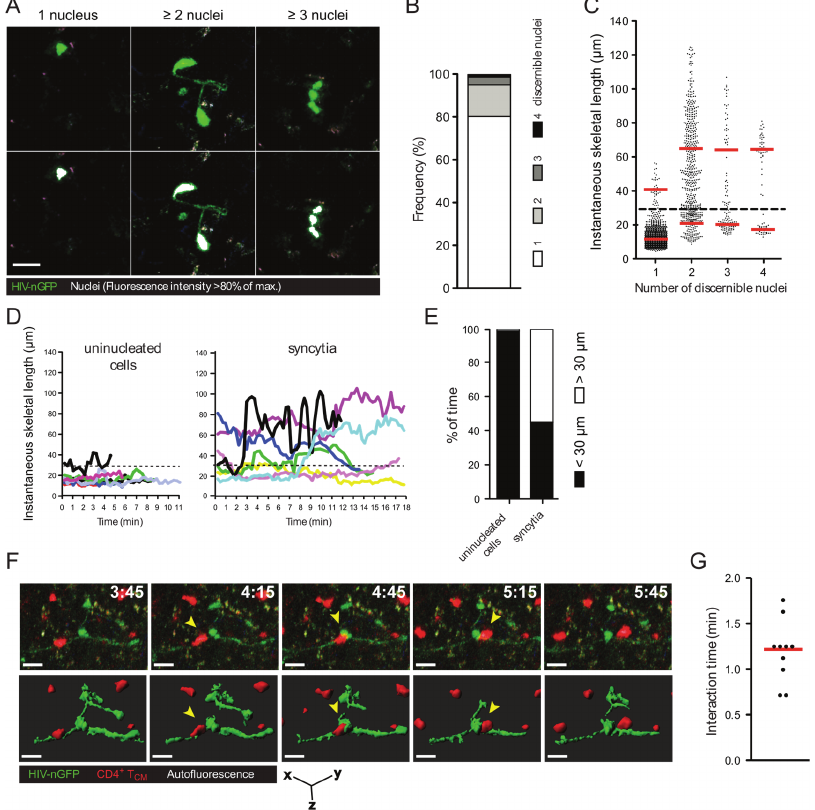
Figure 1. Morphology, frequency, and cellular interactions of HIV-1-induced syncytia in the lymph node. ( A ) Intravital micrographs of lymph node cells infected in situ with HIV-nGFP (day 2) reveal both individual infected cells and multinucleated syncytia. In the bottom panels, the nuclei of infected cells, whose location is identified by a discrete increase in fluorescence intensity, are rendered white, based on an 80% of maximum fluorescence intensity threshold; ( B ) Frequency of HIV-1-infected cells with increasing numbers of discernable nuclei; ( C ) Instantaneous skeletal lengths of individual infected cells and multinucleated syncytia. Red lines indicate means. A threshold length of 30 microns (dotted line) was used to differentiate between coordinate vs. uncoordinated movements. Data from 8 movies recorded in two independent experiments are shown; ( D ) Representative traces of HIV-1-infected lymph node cells showing instantaneous skeletal lengths over time; ( E ) Percent of time an individual infected cell or a multinucleated syncytium displayed coordinated and uncoordinated movements, based on a skeletal length threshold of 30 microns. Data from 8 movies recorded in two independent experiments are shown; ( F ) 3D time-lapse image sequence of a transient cellular interaction between an HIV-1-induced syncytium (HIV-nGFP; green) and an uninfected T cell (CMTMR-labeled; red) in the lymph node of BLT mice. In the bottom panel, 3D cellular surface rendering shows the transient nature of the contact. Elapsed time in min:s. Yellow arrowheads indicate the interacting uninfected T cell. Scale bar = 15 µ m; ( G ) Interaction times between HIV-1-induced syncytia and uninfected T cells. Data from 2 movies ( n = 9) is shown. Red line indicates the median.